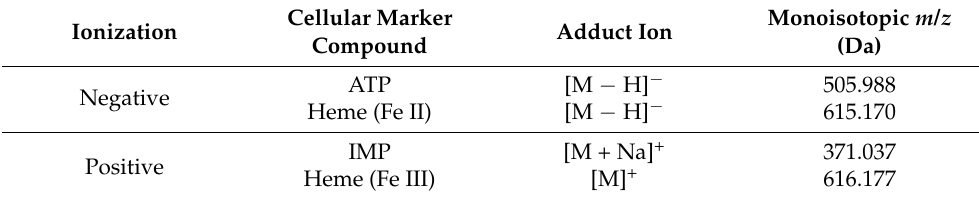
Table 3. Cellular marker compounds used as the MSI quality